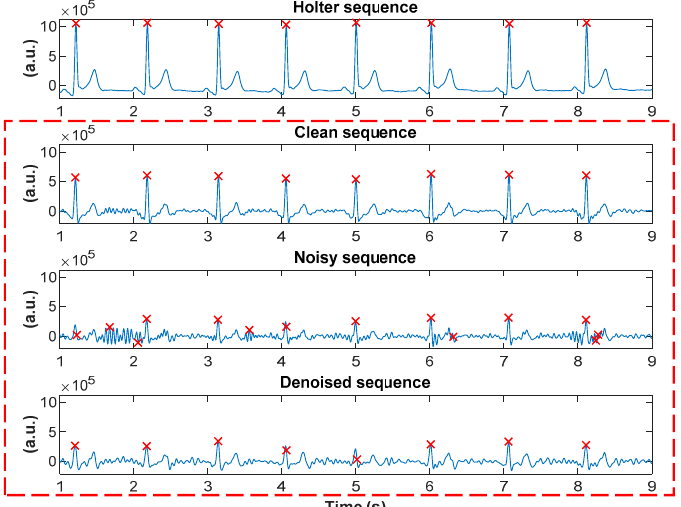
Figure 4. An example of the Holter sequence, corresponding clean armband sequence, a typical noisy armband sequence, and denoised signal after applying the proposed algorithm. R-peaks detected with the Pan and Tompkins algorithm are presented as red ‘x’ signs.